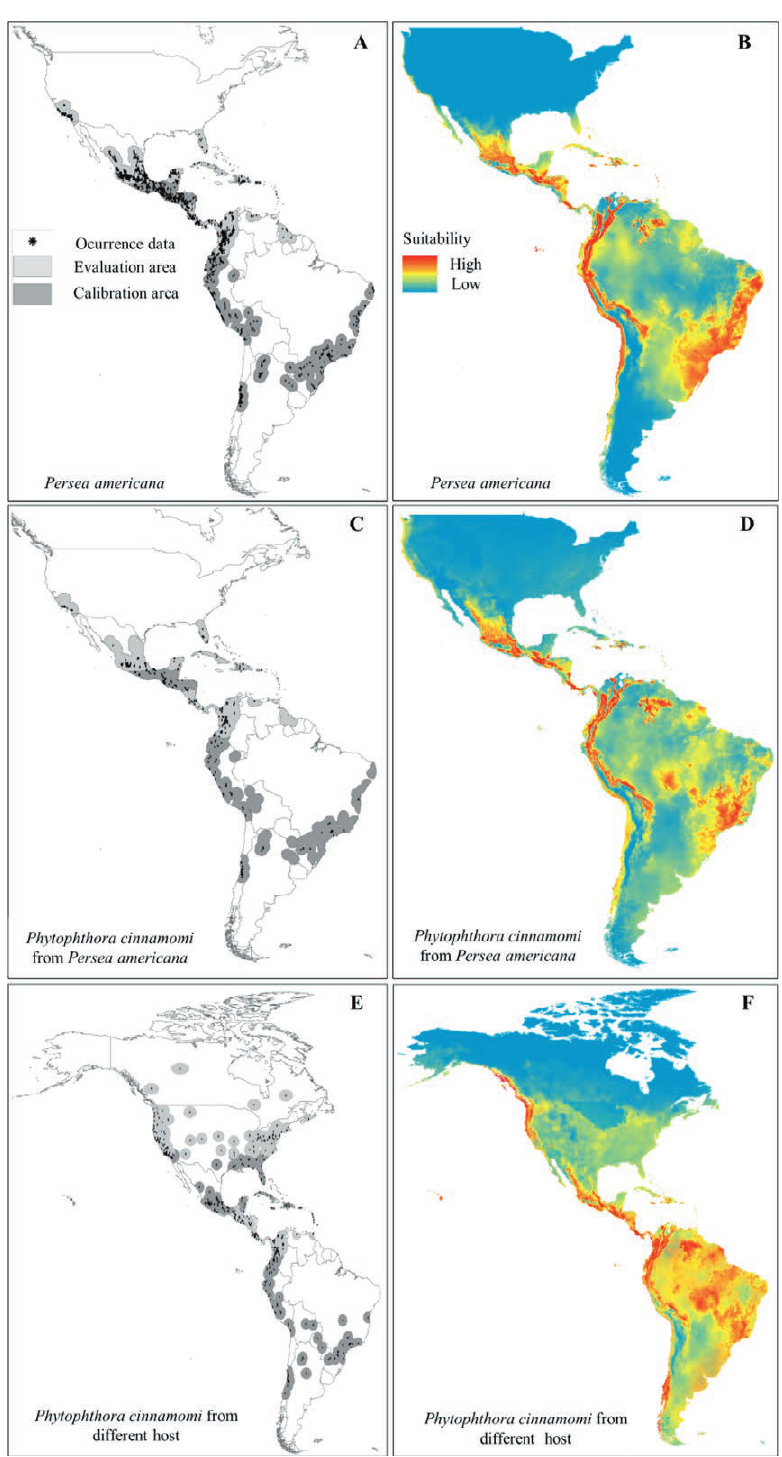
Figure 1. Potential distributions of Persea americana and Phytophthora cinnamomi under present environmental conditions in North and South America. Model calibration and evaluation areas (dark and light grey), and presence (black dots) data, documenting occurrences Per- sea americana , Phytophthora cinnamomi from Persea americana , and P. cinnamomi from hosts different to avocado (A, C, and E). Potential distribution of P. americana , P. cinnamomi from P. americana , and P. cinnamomi from all hosts (B, D, and F) under current environmental conditions in America. The map is the median of the logistic suitable index across the 10 replica models reported in Table